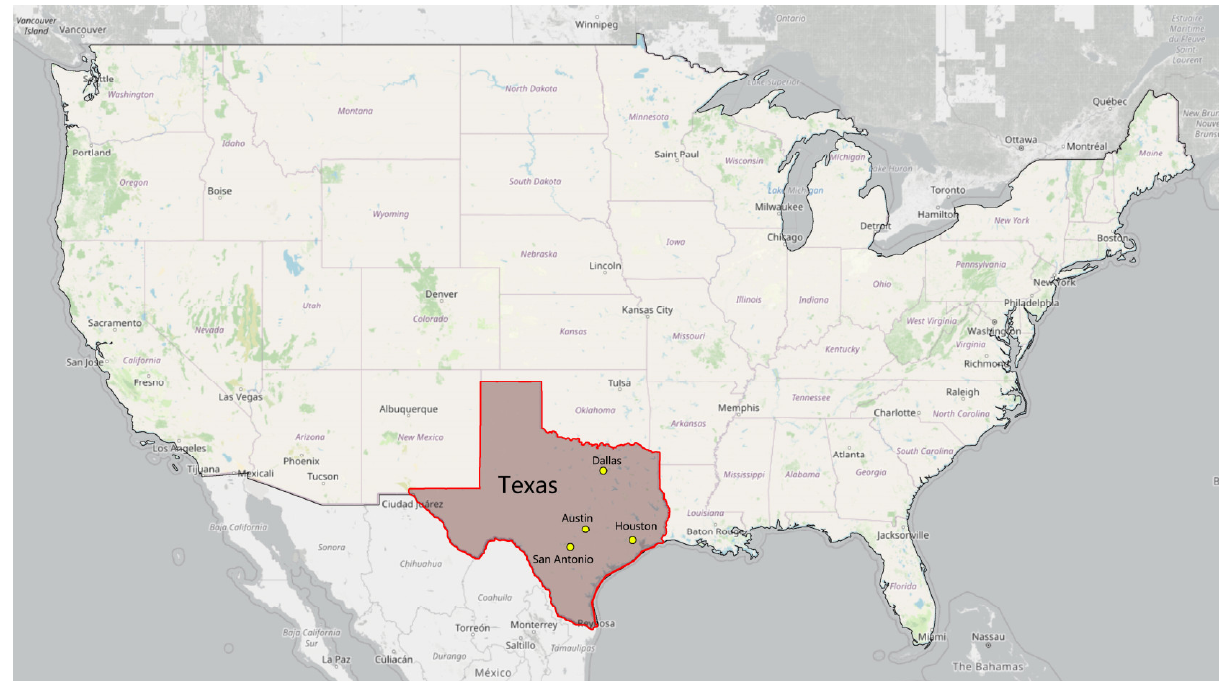
Figure 1. Location of Texas.